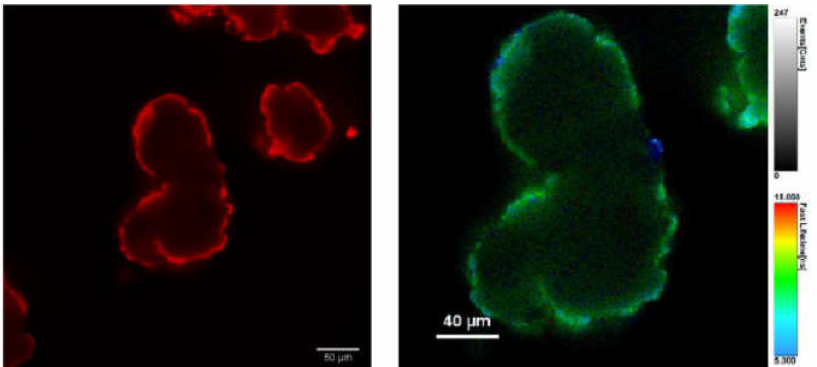
Figure 6. Confocal scanning fluorescence images of PVC particles after 2 h incubation with P (8 µ M) in buffered water (pH = 7): ( Left ) excitation at 489 nm and detection at 595/50 nm; and ( Right ) FLIM image showing the local excited state